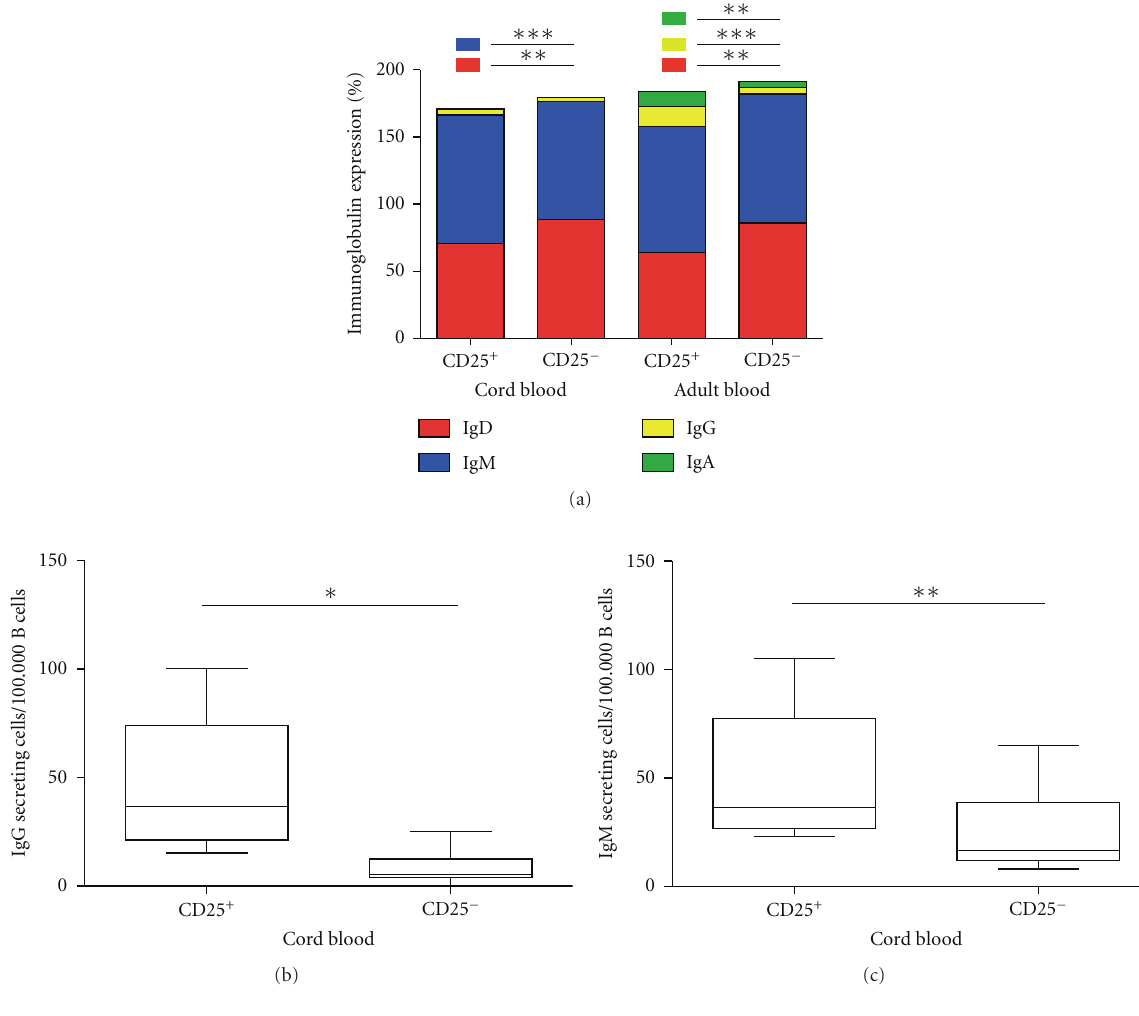
Figure 3: Analysis of surface immunoglobulin expression and secretion from CD25 + and CD25 − CD20 + B cells isolated from cord blood and adult blood. In (a) freshly isolated cord blood ( N = 10) or adult blood, mononuclear cells ( N = 10) were isolated by density gradient centrifugation. Cells were stained for 3-colour flow cytometry analysis using a combination of CD20, CD25, IgG, IgA, IgM, and IgD. In (a), a summary of all 4 surface immunoglobulins expressed by the CD20 + CD25 + or CD20 + CD25 − B cells is shown. Red colour represents IgD, blue colour represents IgM, yellow colour represents IgG, and green colour represents IgA. In (b) and (c), freshly isolated cord blood mononuclear cells ( N = 6) were isolated by density gradient centrifugation followed by flow cytometry sorting into CD20 + CD25 + or CD20 + CD25 − populations. These populations were then analysed for the capacity to secret either IgG (b) or IgM (c) by use of ELISPOT. Line in boxes represents median. Statistical evaluation was performed using the parametric unpaired t -test when comparing results from cord blood versus results from adult blood, whereas when comparing results within each group, the paired t -test was used. ∗ P ≤ 0 . 01, ∗∗ P ≤ 0 . 001, and ∗∗∗ P ≤ 0 .